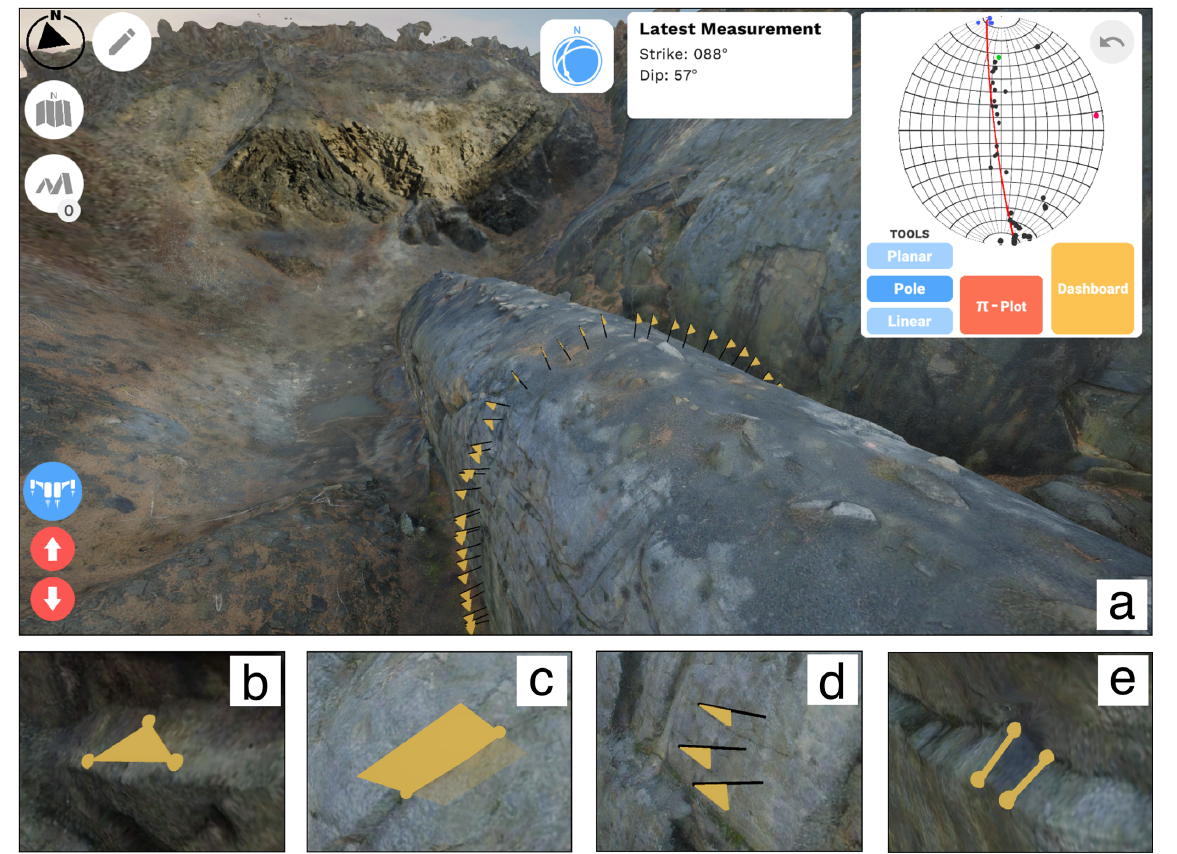
Figure 1. The interface and custom geology tools within our virtual field experiences. (a) A view of the Whaleback anticline while the user is in jetpack mode. From the top right and continuing counterclockwise, the icons on the perimeter enable the user to toggle the stereonet measurement tools, drawing tools, a compass, map (orthographic aerial) view, a linear distance measurement tool, and jetpack mode. Poles to bedding, represented by orange flags, are plotted as a scan line roughly perpendicular to the trend of the fold crest. The stereonet pi plot shows the measured poles and automatically updates as more data are collected. A best-fit great circle and corresponding pole (red line and point on stereonet) calculate the approximate trend and plunge of the fold axis. (b–e) User-constructed representations of measurements include three point planes, two point and rotate planes, poles to planes (flags), and